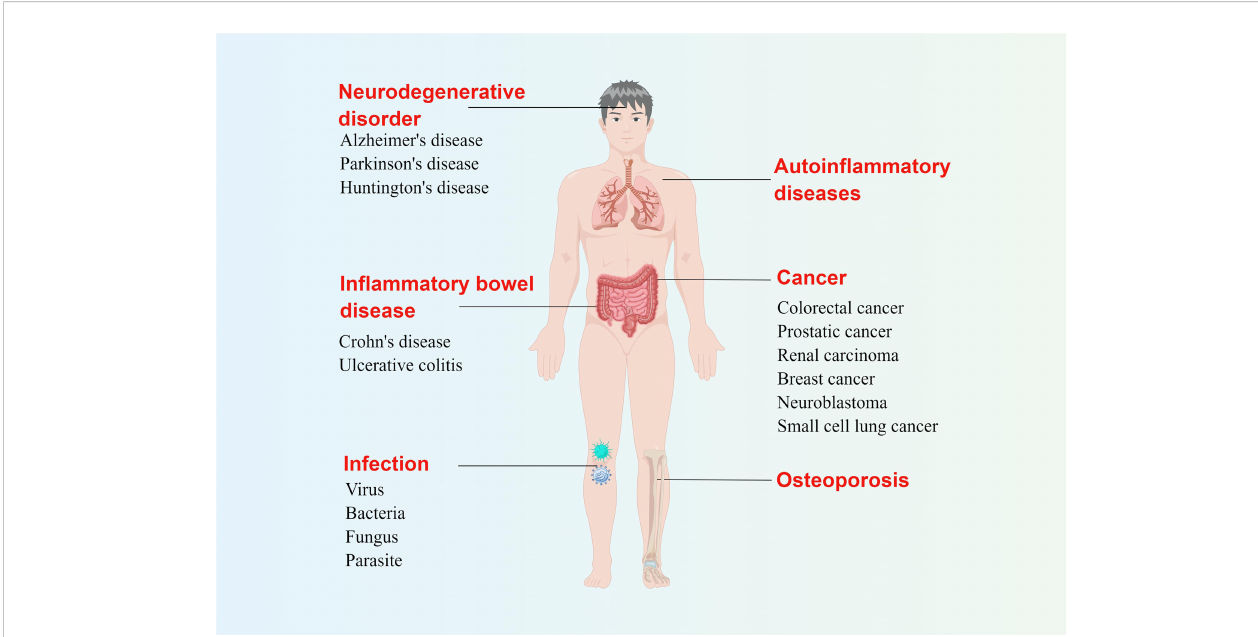
FIGURE 1 Possible diseases related to PANoptosis. Abnormal pyroptosis, apoptosis, or necroptosis can lead to a variety of diseases in the human body. The fi gure illustrates several diseases related to three kinds of programmed cell death at the same time, which are likely related to PANoptosis. By Figdraw (www. fi